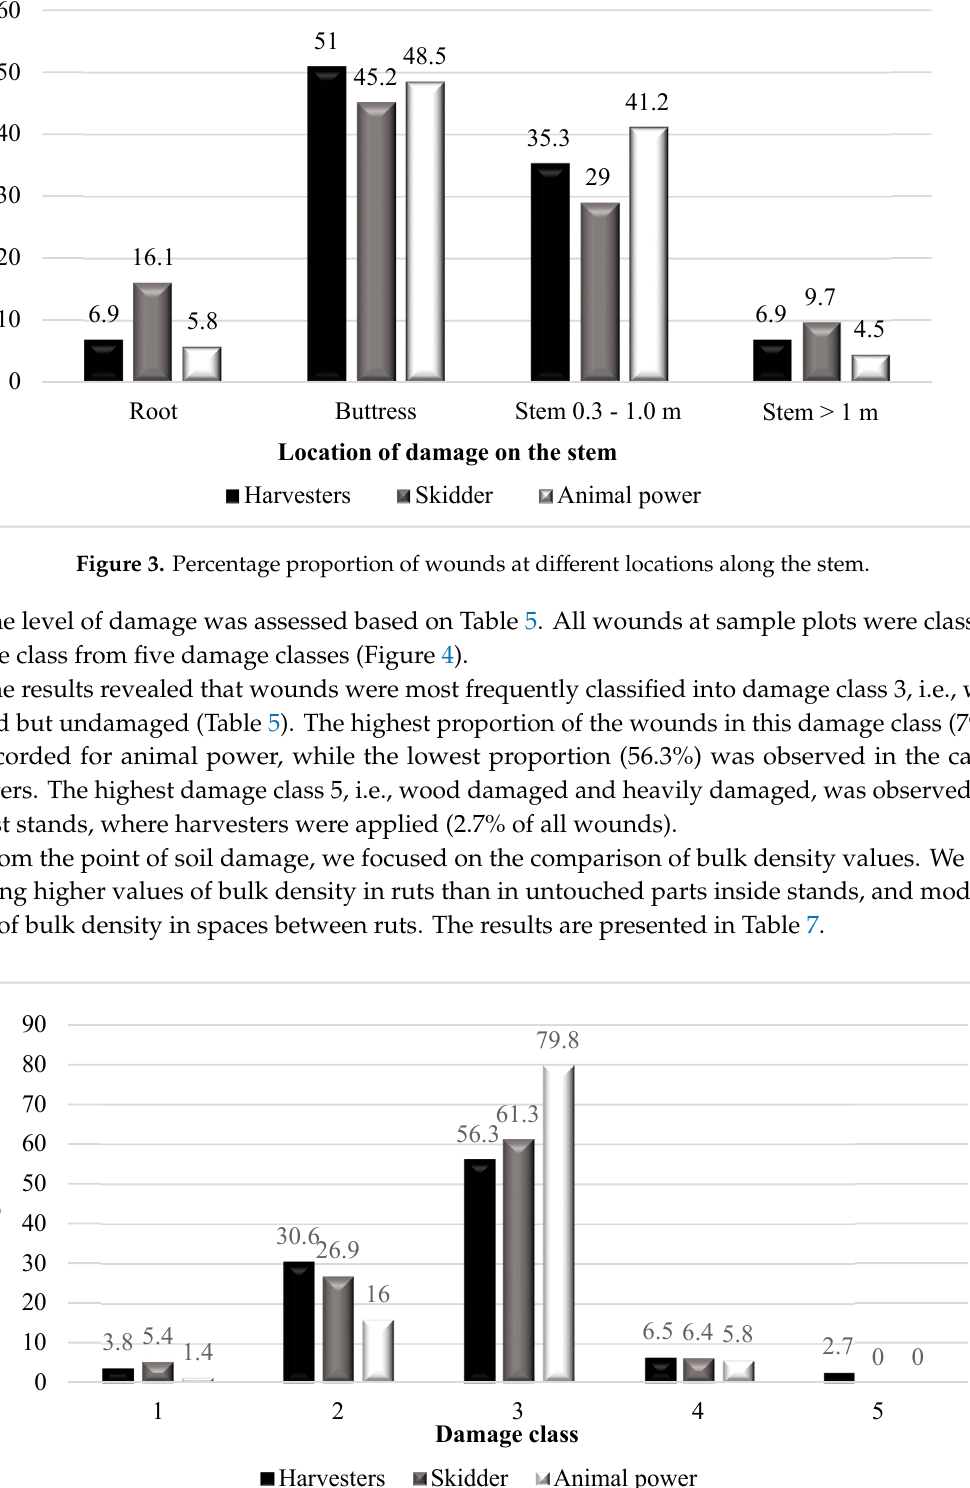
Figure 4. Relative distribution of wounds in individual damage classes (Table 5) with regard to individual applied technologies. Table 7. Comparison of bulk density and soil moisture measured in stands, ruts, and in spaces between ruts (centre).